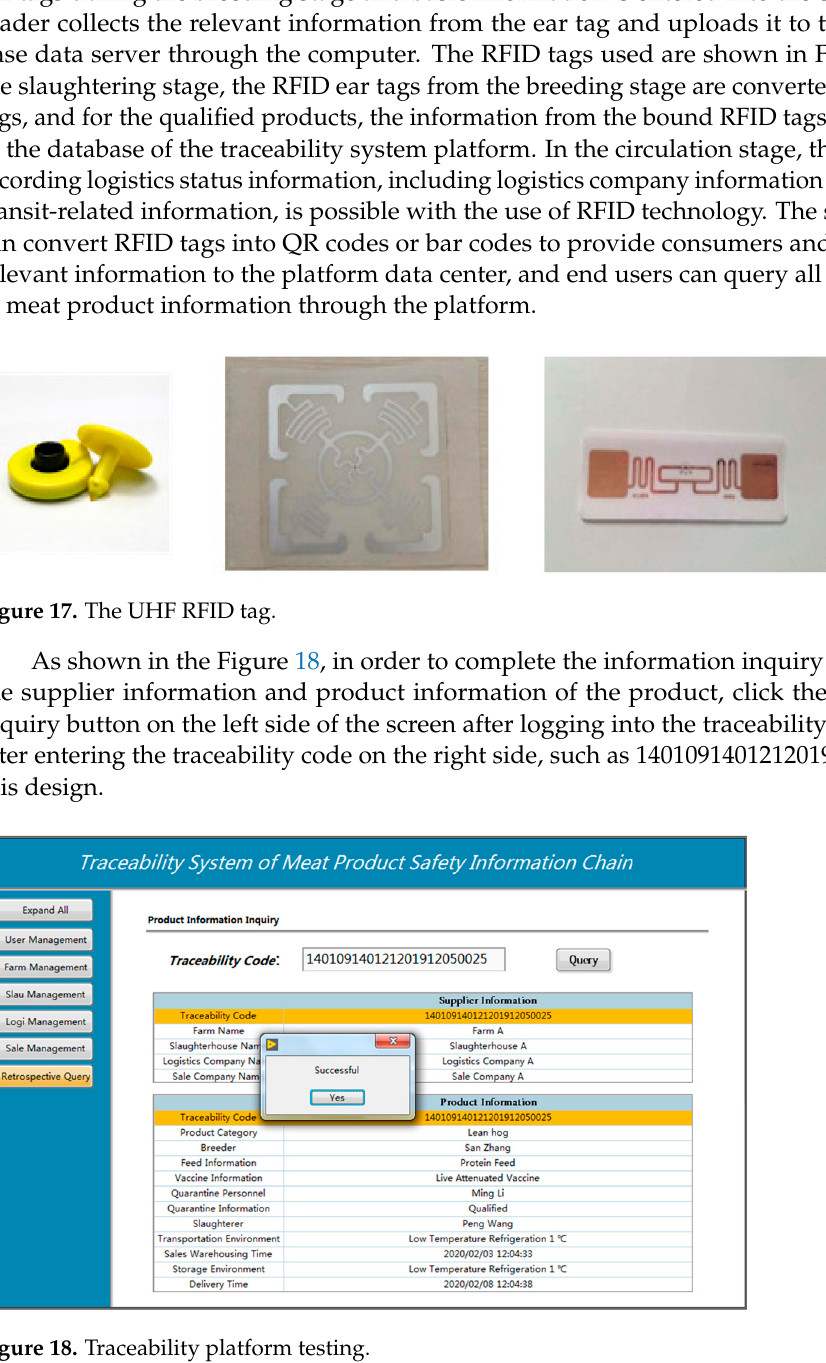
( b ) Figure 16. Test results: ( a ) Network port label data; ( b ) RSSI data analysis. The low cost of the system is one of its signi fi cant advantages. The STM32F103RET6 microcontroller was chosen for the system because it o ff ers a lower-cost platform based on the Cortex-M3 core, fewer pins, and lower system power consumption. The main RF chips on the market are PR9000, AS3992, and R2000. Although these chips perform well,